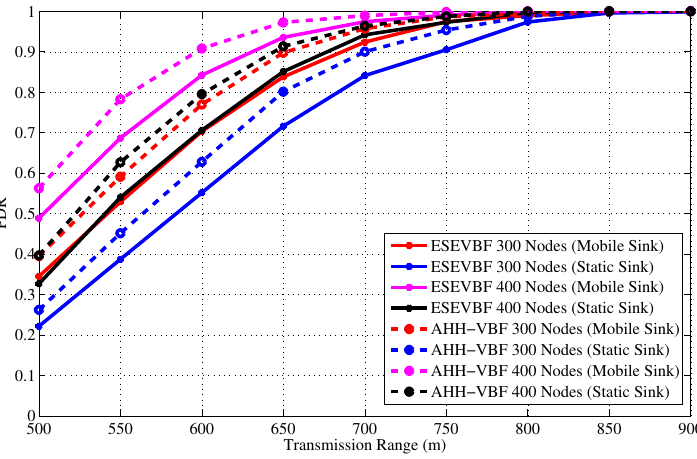
Figure 18. Average packet delivery ration versus the transmission